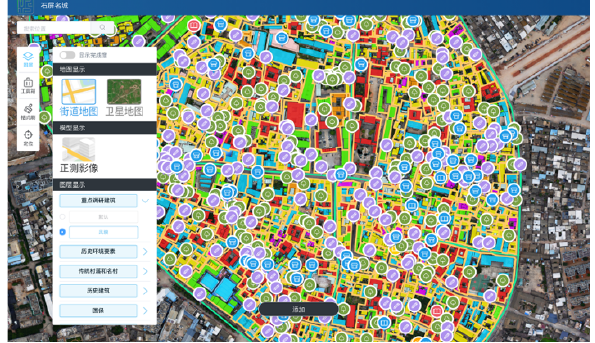
Figure 12 . Collection Results of Shiping Historic City.